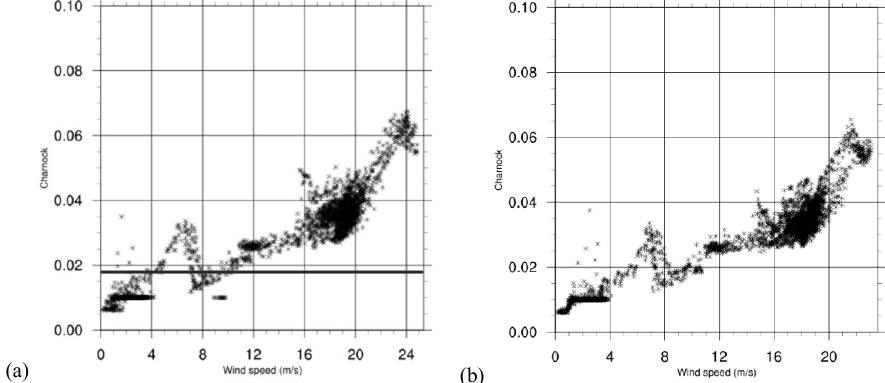
Figure 14. Charnock coefficient dependence to the wind speed in (a) offline coupled simulations. The thick solid line indicates the constant Charnock value (0.018) in the MYJ surface layer parameterization scheme. (b) WEW simulations. The diagrams consist of selected sea points with severe winds during the period 4–11 January 2012.